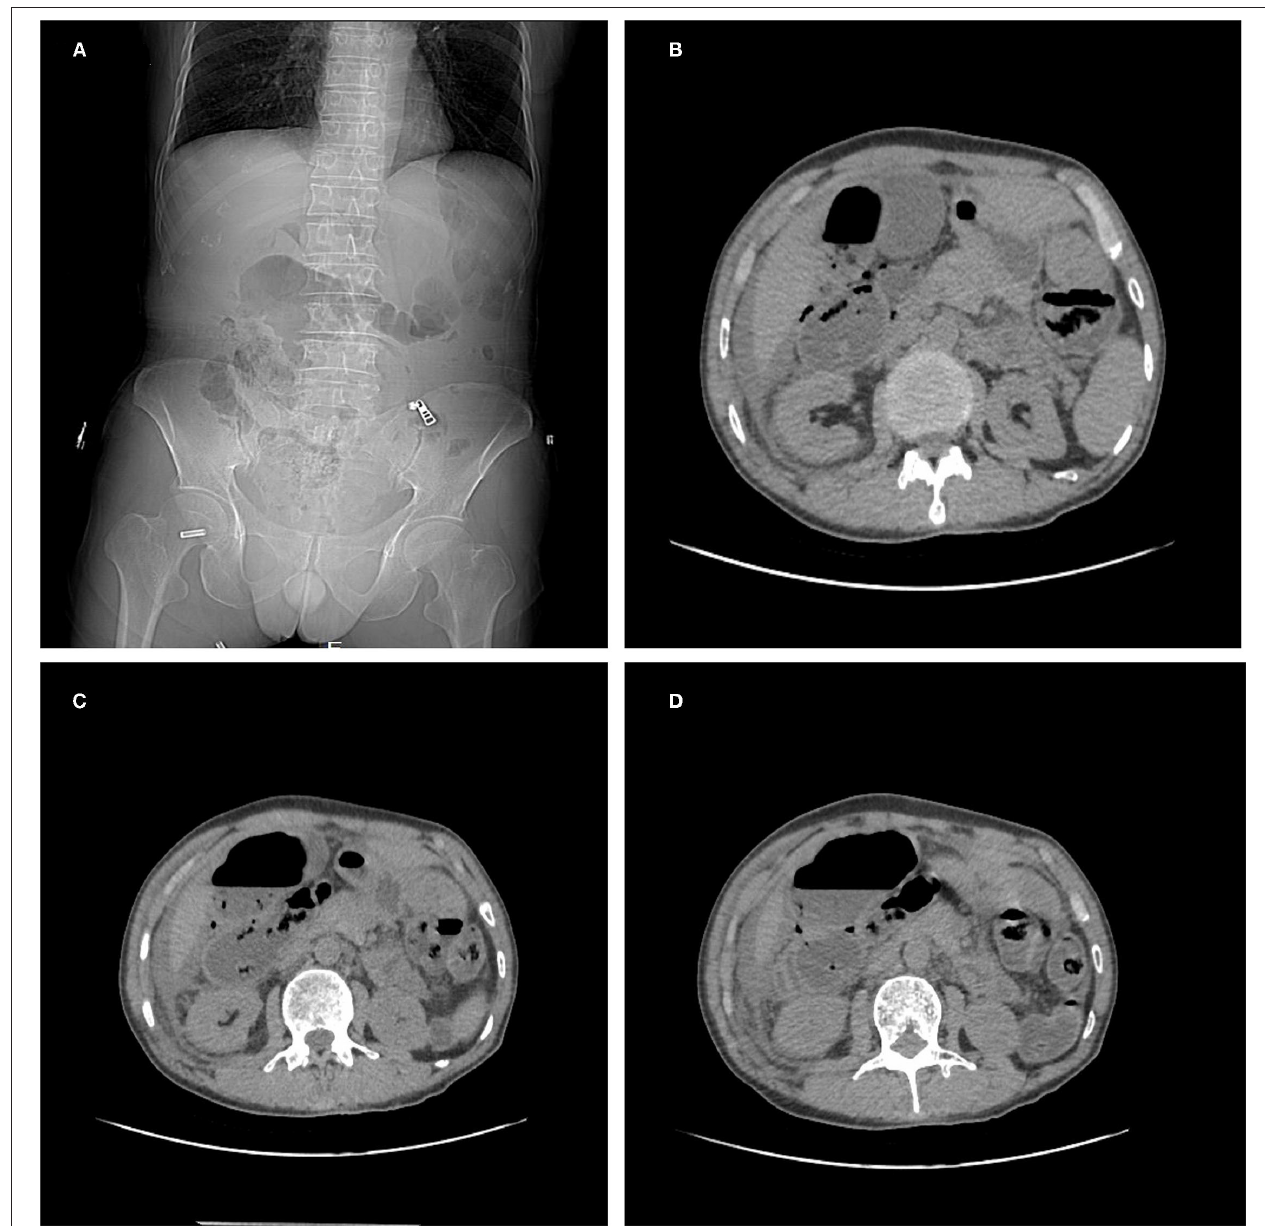
FIGURE 1 | Abdominal CT examination (A–D) : a small amount of free gas in the abdominal cavity, ascites, gastrointestinal